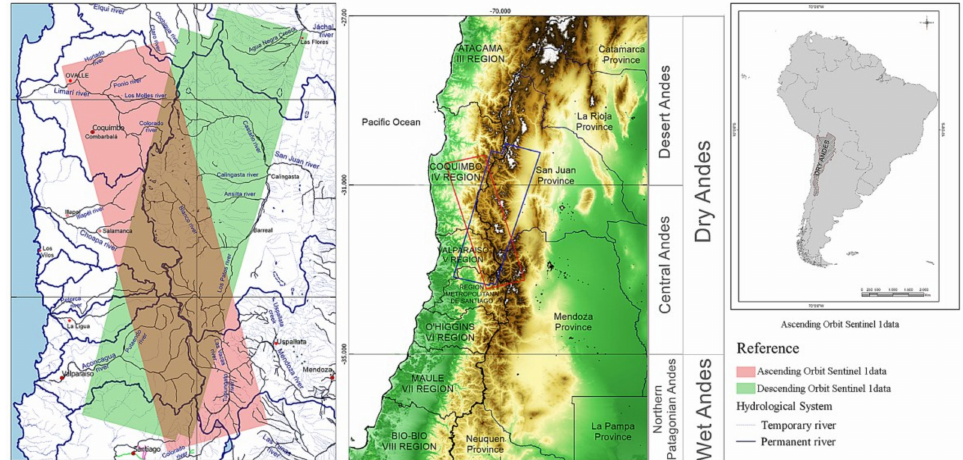
Figure 1. Location of the study area. ( a ) Main river basins, cities, and area covered by ascending and descending orbit Sentinel-1 data. ( b ) Provinces and regions in the Dry Andes of Argentina and Chile. ( c ) Regional location of the Dry Andes in South